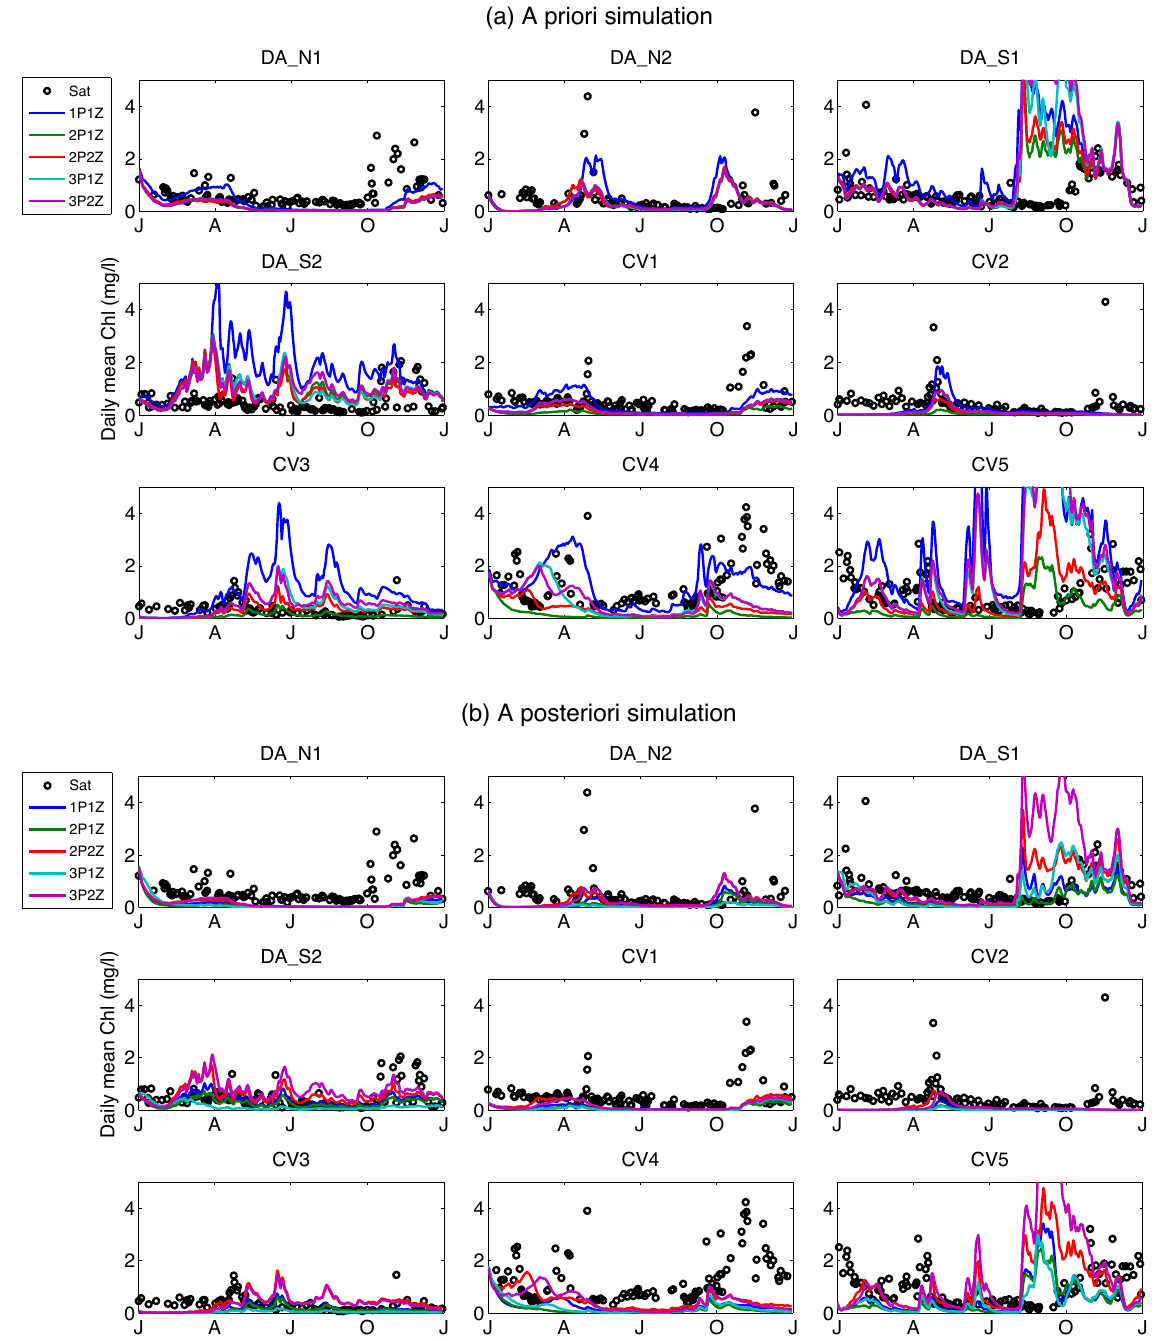
Figure 2. Time series of total surface chlorophyll from the satellite-derived data (open black circles) and the (a) a priori and (b) a posteriori simulations (lines) at the nine study sites for the five ecosystem models.